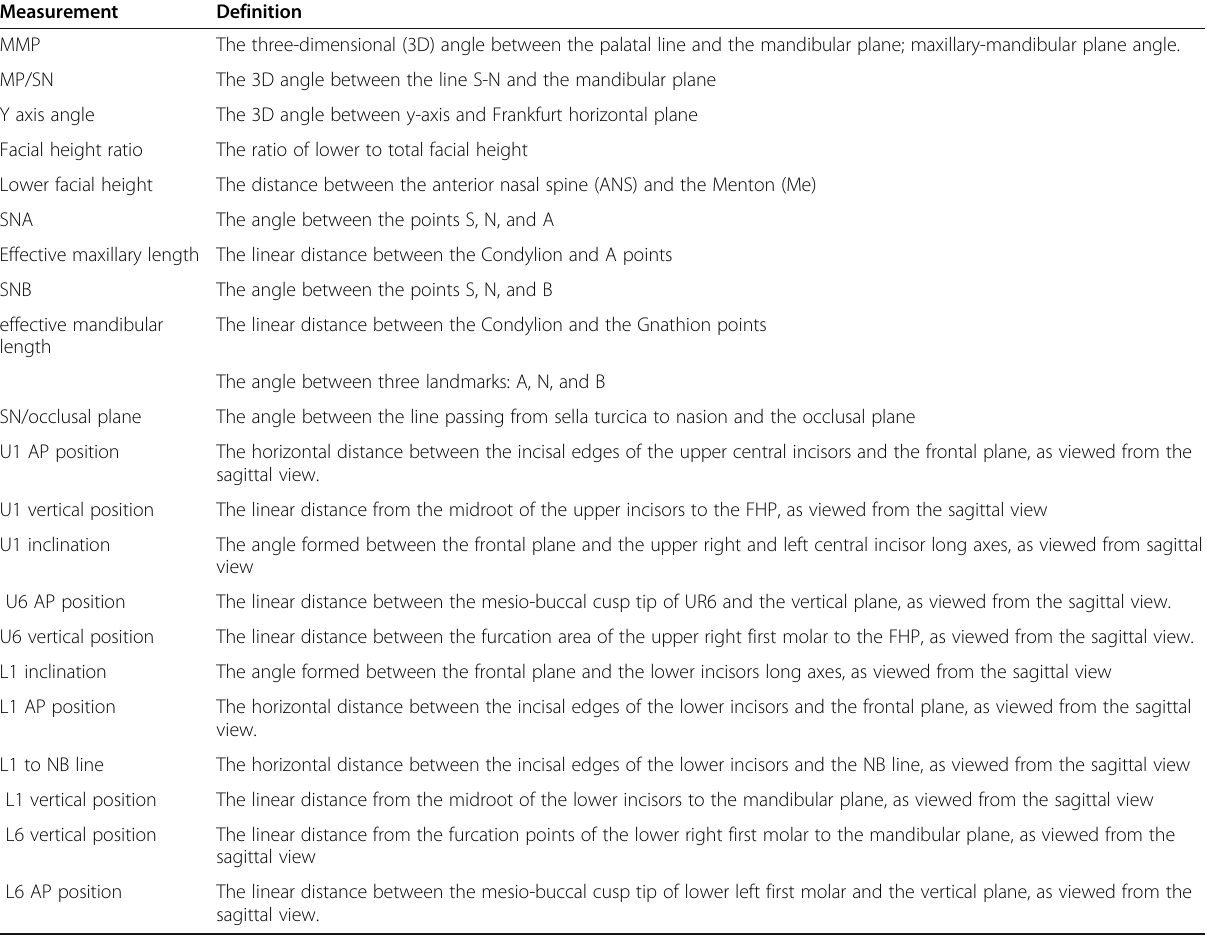
Table 1 Definitions of the included measurements in the